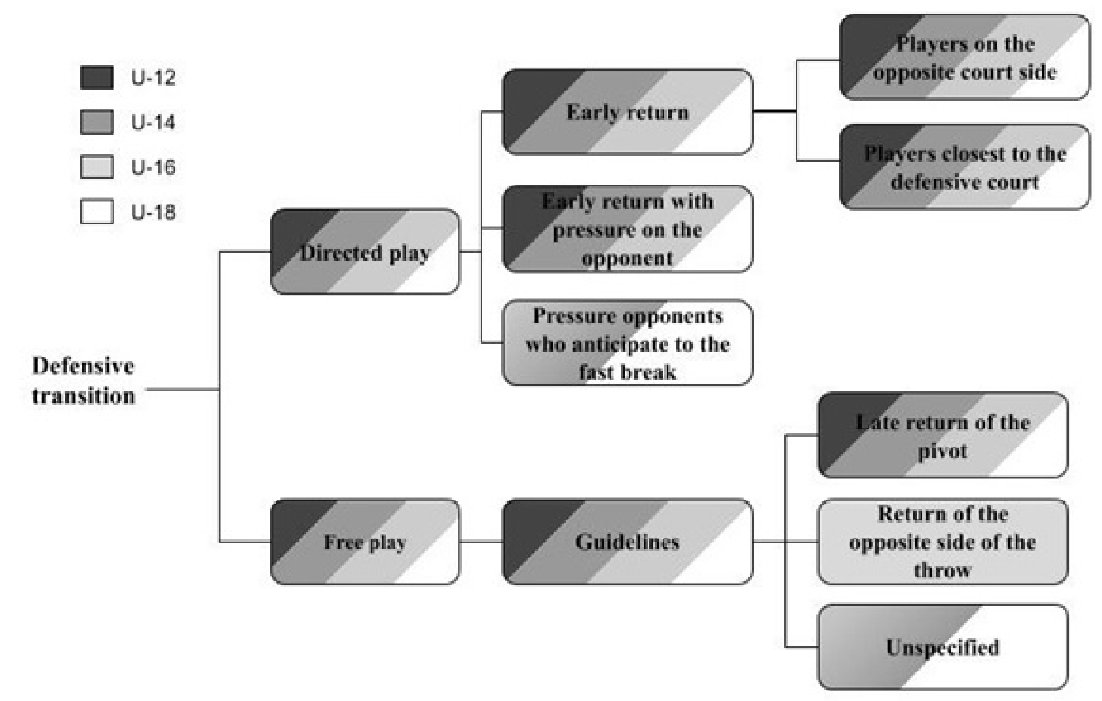
Figure 1 - Thematic map of defensive return structures